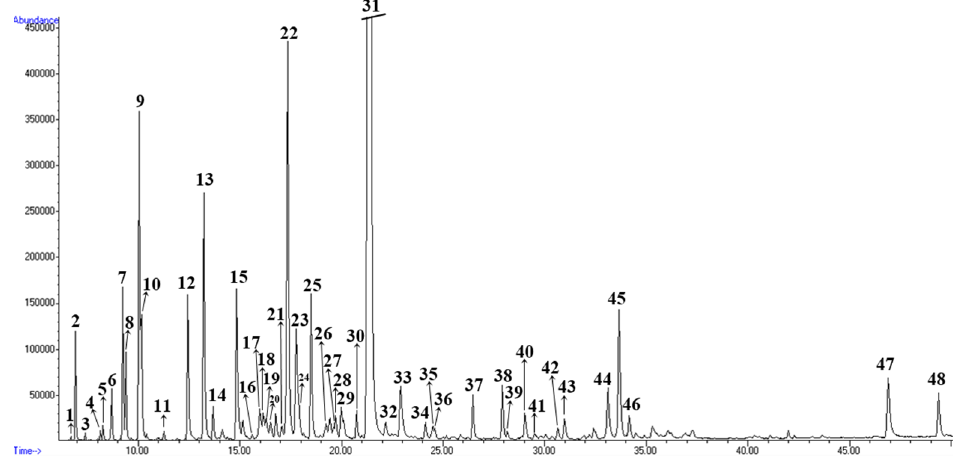
Figure 2. GC/FID chromatogram of essential oil isolated from wild fennel stem. Table 2. Chemical composition of essential oil isolated from wild fennel In addition to the most common components from fennel stem (E-anethole and me- thyl chavicol), the following components are somewhat less present: p -cymene (3.9%), cis-